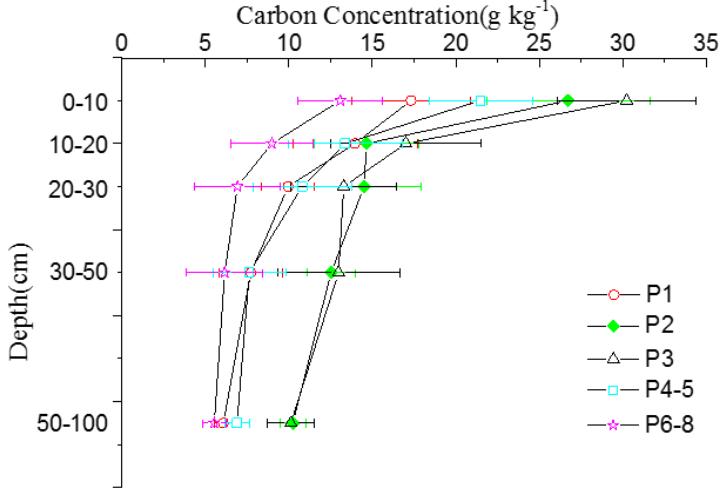
Figure 2. General pattern of bulk density in soil of the Eucalyptus plantation.